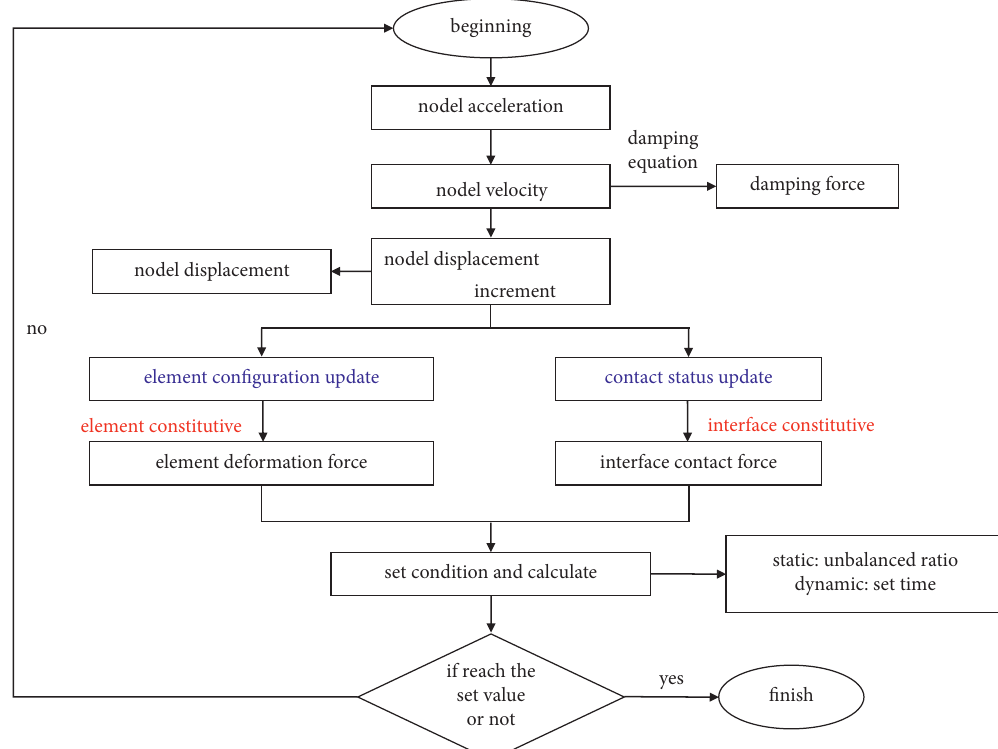
Figure 3: The basic iterative process of CDEM.